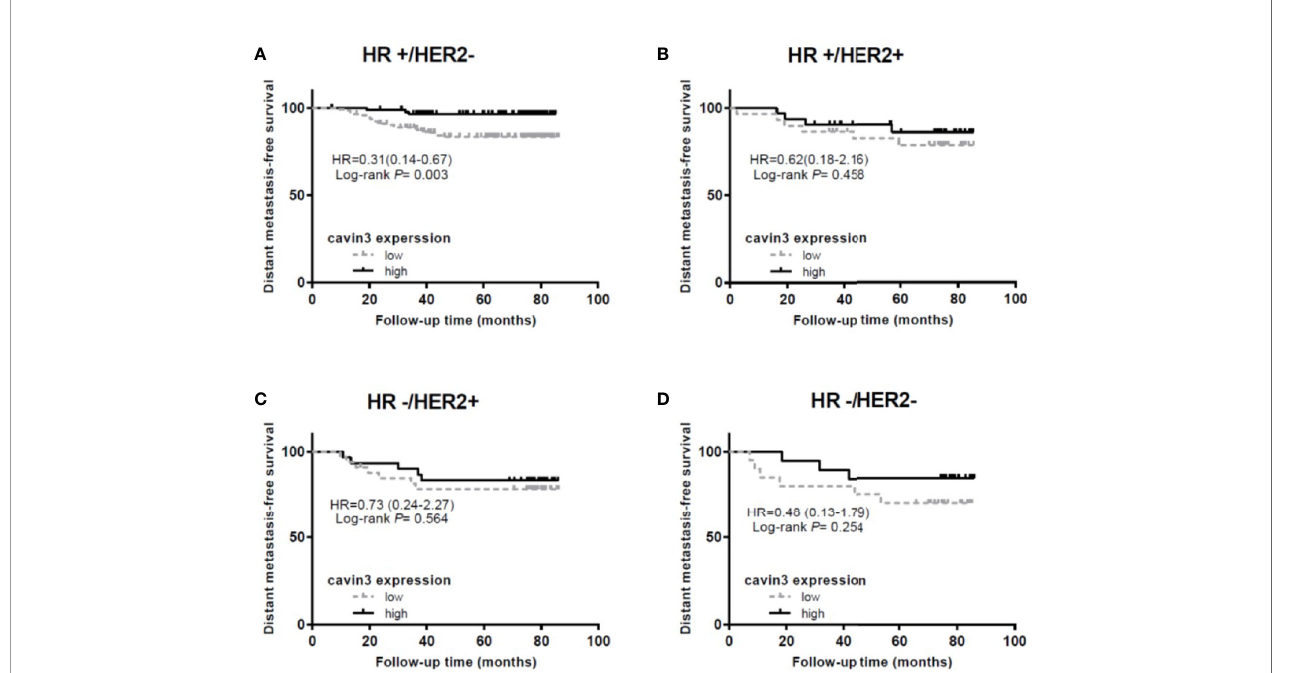
FIGURE 3 | Impact of cavin3 protein expression on distant metastasis-free survival strati fi ed by IHC-based molecular subtypes. (A) HR+/HER2- subtype; (B) HR +/HER2+ subtype; (C) HR-/HER2+ subtype; (D) HR-/HER2- subtype; HR, hormone receptor; HER2, human epidermal growth factor receptor-2.